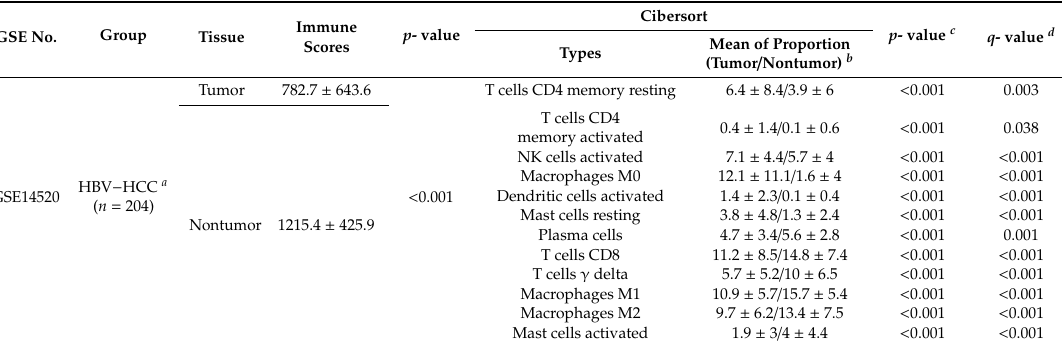
Figure 3. The relative composition of TILs in the intra-tumor and non-tumor tissue using CIBERSORT. The datasets used for these visual outputs were (left) HBV − HCC: GSE14520; (center) HCV − HCC: GSE17856 and GSE10143; (right) HCC: GSE74627, GSE54236, GSE10143, GSE14520, and GSE17584. All immune cell types were evaluated, but only the statistically significant ones are labeled on the plot. p -value was calculated by a Wilcoxon rank-sum test and then adjusted by Bonferroni correction ( q -value). The red dotted line on the y -axis indicates a q -value of 0.05 ( > 0.05: non-significant; ≤ 0.05: significant) whereas the one on the x -axis indicates a Z score of 0 ( > 0: relatively higher abundance in tumor tissue; < 0: relatively higher abundance in non-tumor tissue). Table 2. The comparative composition of TILs in HBV −